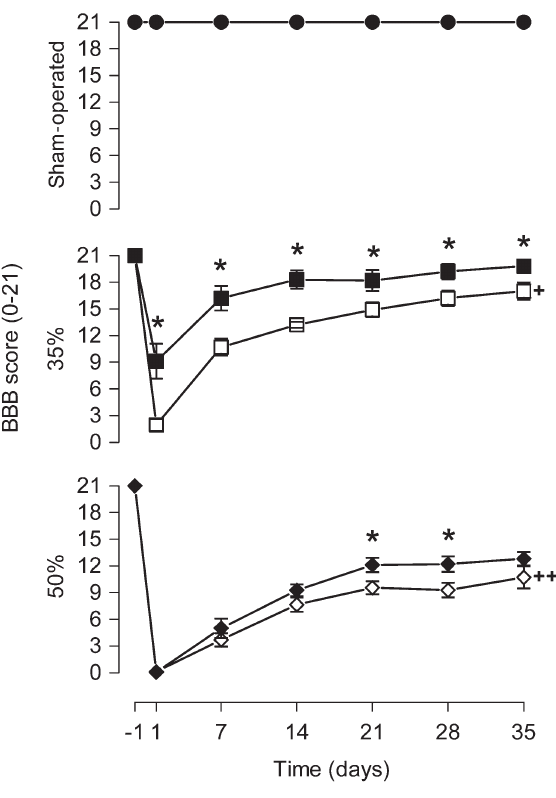
Figure 4. Melatonin treatment improved the BBB score. Results of the Basso, Beattie and Bresnahan (BBB) locomotor scale measured 24 h before (-1) and 1, 7 14, 21, 28, and 35 days after narrowing of the spinal cord canal. Each point represents the mean ± SE for 9-11 rats. *P , 0.05 compared to the vehicle- treated group (independent Student t -test). + P , 0.0001 compared to sham-operated group from vehicle-treated animals, at all times after narrowing of the spinal cord canal (ANOVA with the Duncan post hoc test). ++ P , 0.0001 compared to sham- operated group and 35% narrowing from vehicle-treated animals, at all times after narrowing of the spinal cord canal (ANOVA with the Duncan post hoc test). 35% = 35% narrowing group; 50% = 50% narrowing group. Open symbols = vehicle-treated groups; filled symbols = melatonin-treated